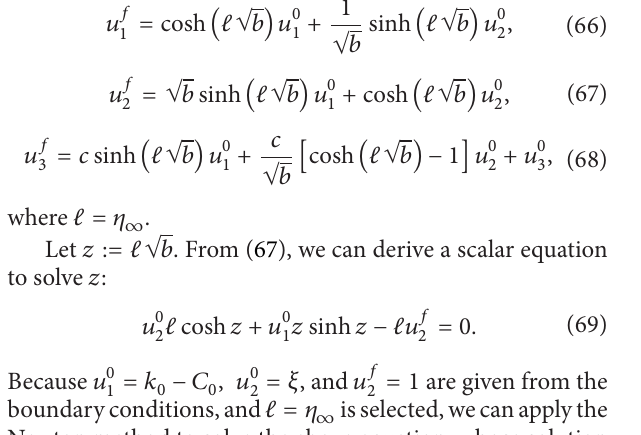
Figure 9: The boundary layer problem of a power-law fluid with 𝑁 = 0.8 solved by the SL (3, R ) method, (a) showing the error of mismatching and iterations number and showing the numerical solutions of (b) 𝑓 , (c) 𝑓 󸀠 , and (d) 𝑓 󸀠󸀠